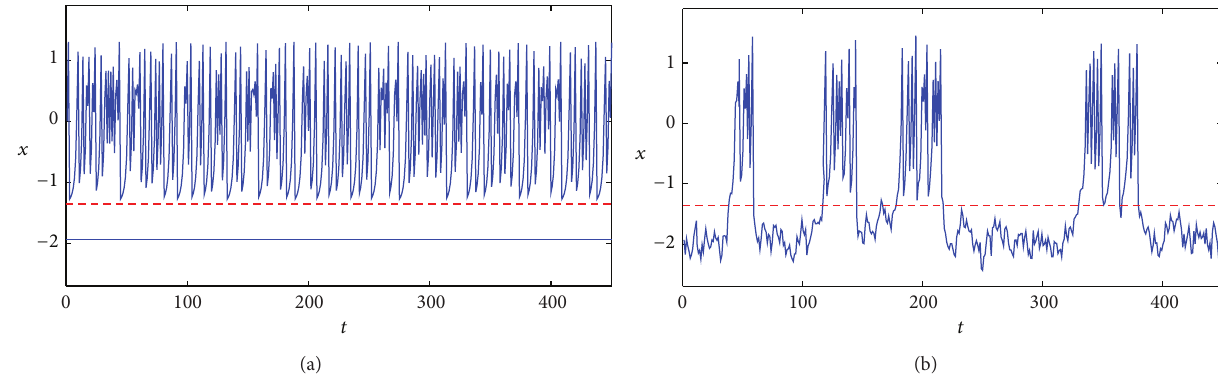
Figure 3: Time series for Rulkov model with 𝛾 = −2.8 : (a) 𝜀 = 0 , and (b) 𝜀 = 0.15